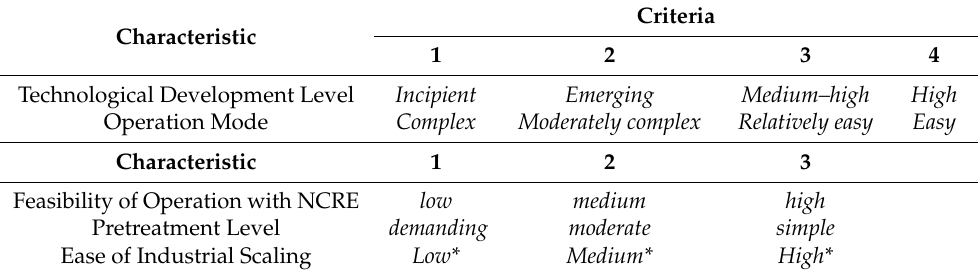
Table 3. Criteria to analyze the industrial scale-up potential (category 2). Criteria Parameter 0 0.5 1 Water quality according to regulations Low quality Medium quality High quality Productivity, quality, and cost vs. RO Worst Equal Best Innovations in the operation Worst* Equal* Best* Integration of renewable energy None Partial